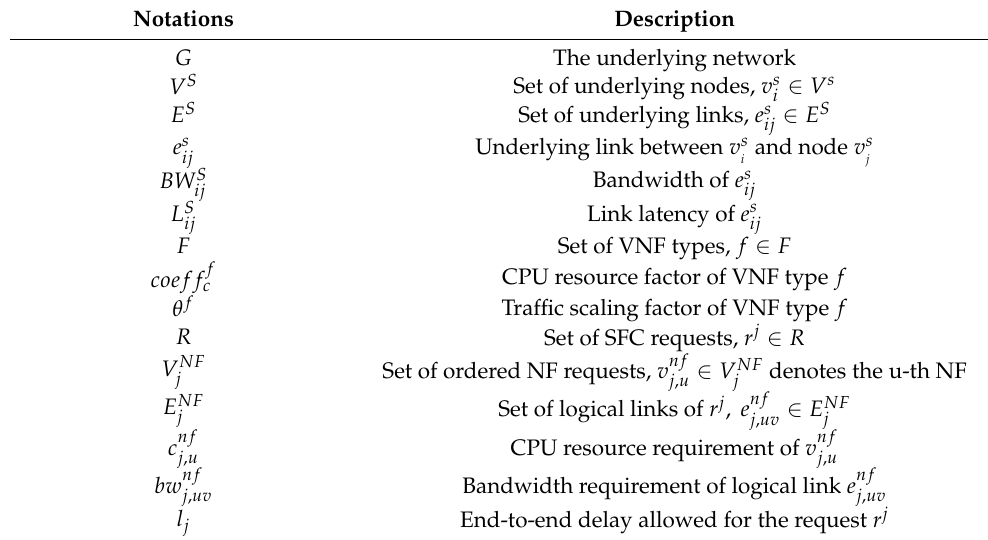
Table 1. Notations used in the